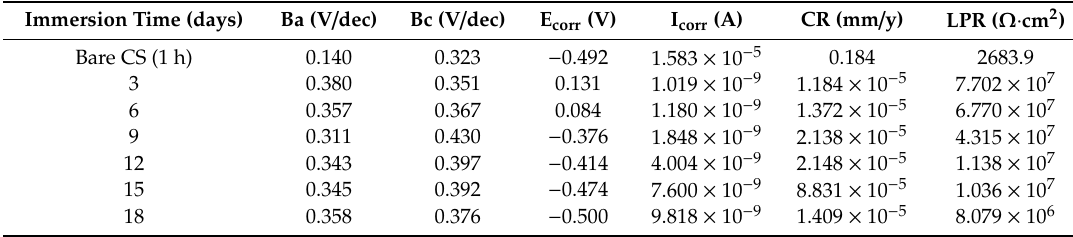
Figure 9. ( a ) Electrochemical Impedance Spectroscopy (EIS) spectra of CAPUOA / FS2 and ( b ) Tafel spectra of CAPUOA / FS2. Table 3. Potentiodynamic parameters for bare mild steel (MS) and CAPUOA / FS2 nanocomposite coated MS after immersion in 3.5% NaCl solution at room temperature.